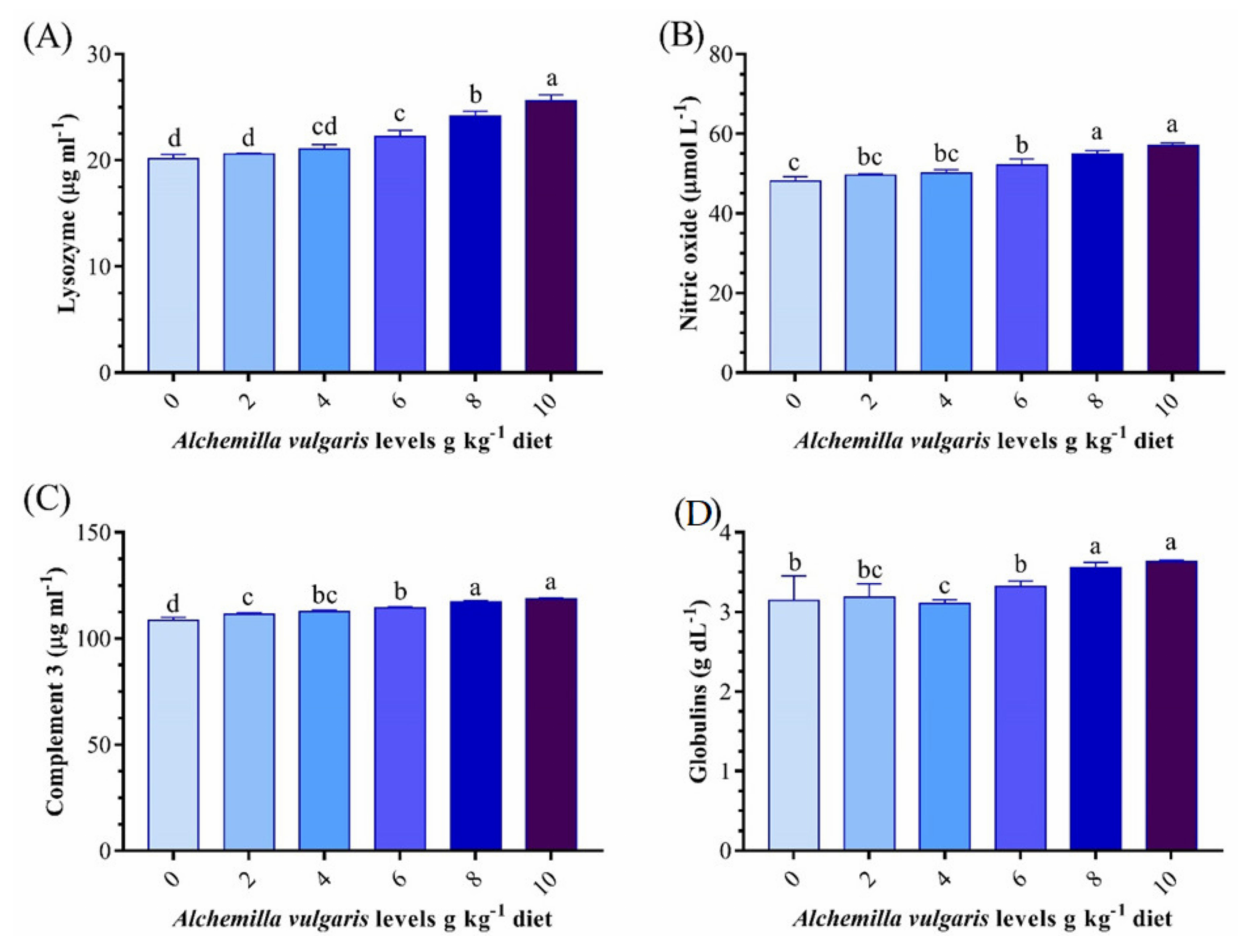
Figure 2. Effect of Alchemilla vulgaris dietary supplementation on innate immune parameters of O. niloticus for 60 days. ( A ) lysozyme, ( B ) nitric oxide, ( C ) complement 3, ( D ) globulin. Columns bearing different letters are significantly different at p <